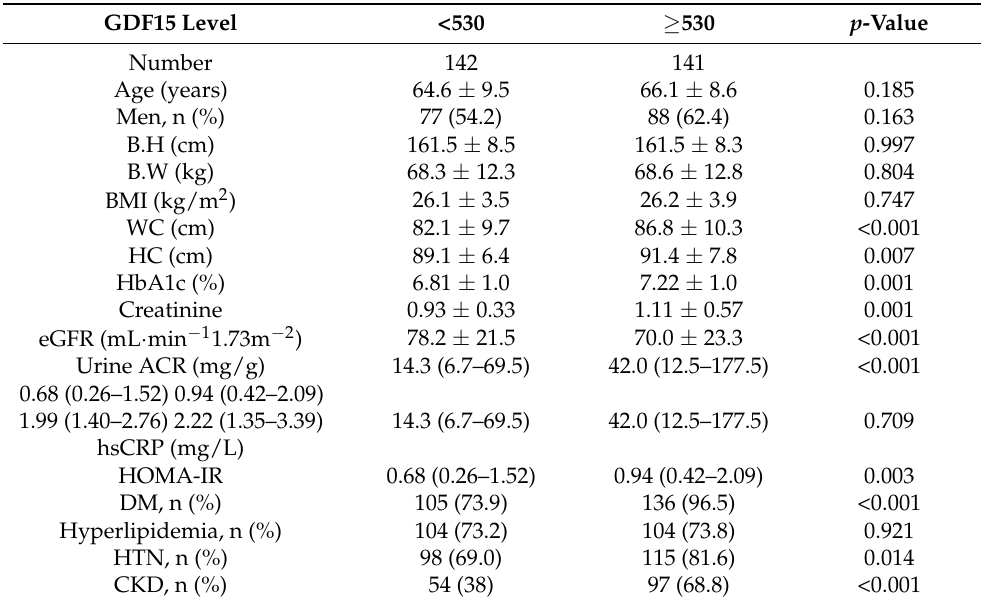
Table 3. Comparisons between high and low GDF level.